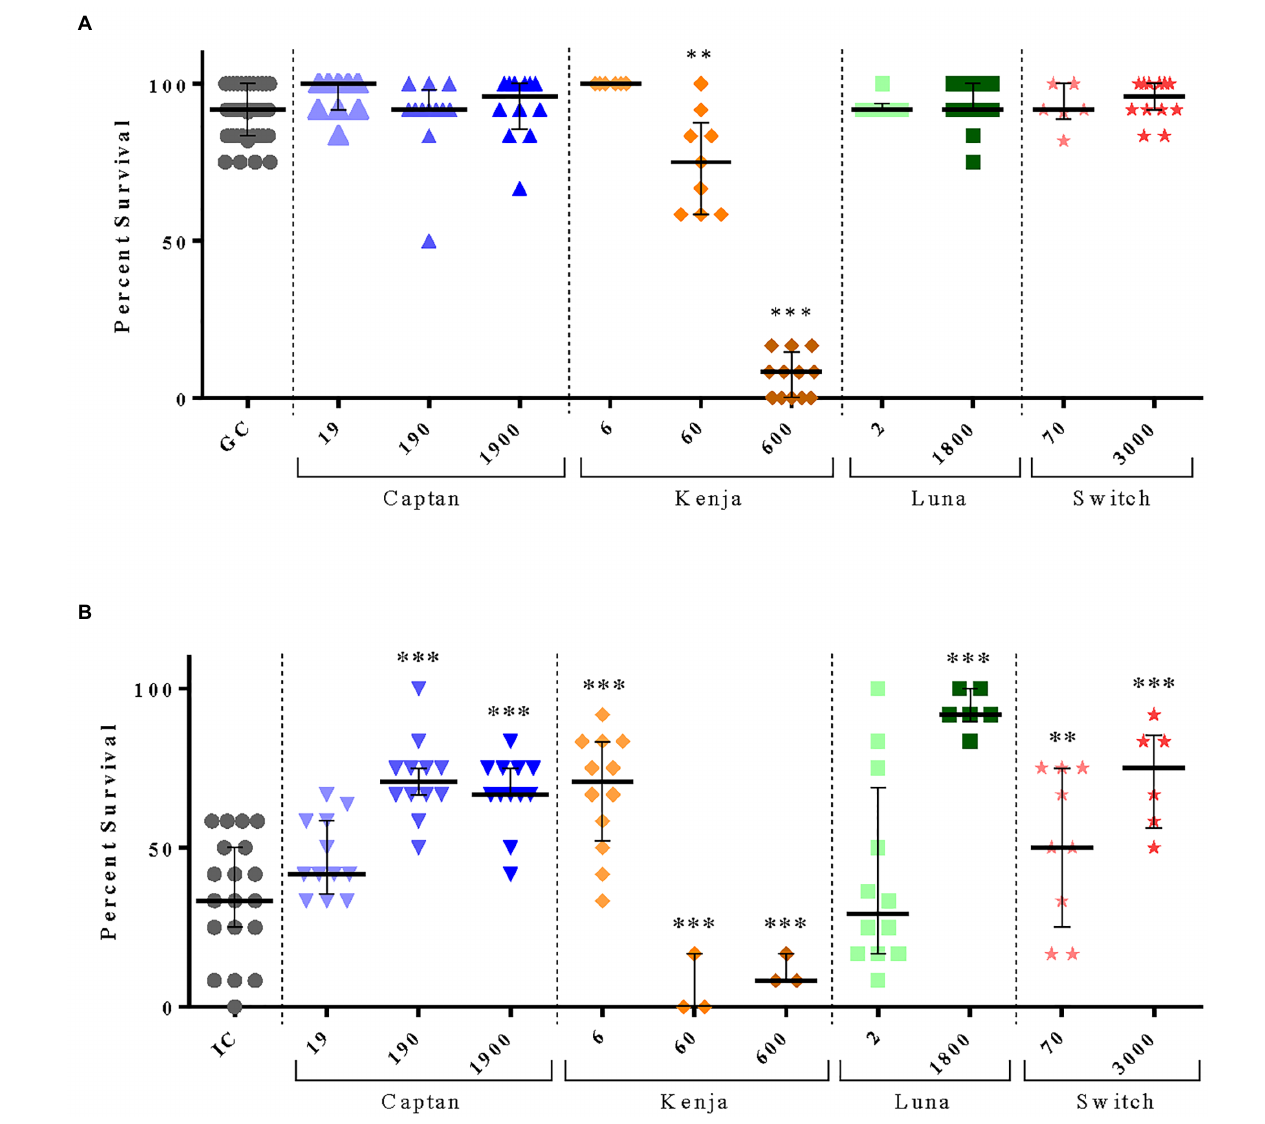
FIGURE 3 Effect of chronic fungicidal exposure on larval survival from European foulbrood disease in vitro. Honey bee larvae were reared in vitro for 6 days and chronically exposed to low, medium, and high concentrations of four different formulated fungicidal products. (A) Percent survival of 60–144 larvae chronically administered fungicidal product and compared to 501 grafting control (GC) larvae. (B) 36–144 larvae infected with 50 CFU of M. plutonius bacteria, chronically exposed to fungicides, and compared to 228 infected control (IC) larvae. Each dot represents one replicate ( n = 12 larvae). Numbered categories on the x -axis represent the concentrations of the active fungicidal ingredient in ng/bee. Horizontal and vertical lines overlying the dots represent the median and interquartile range, respectively. ** p < 0.01, *** p < 0.001, by a Pearson’s chi-squared